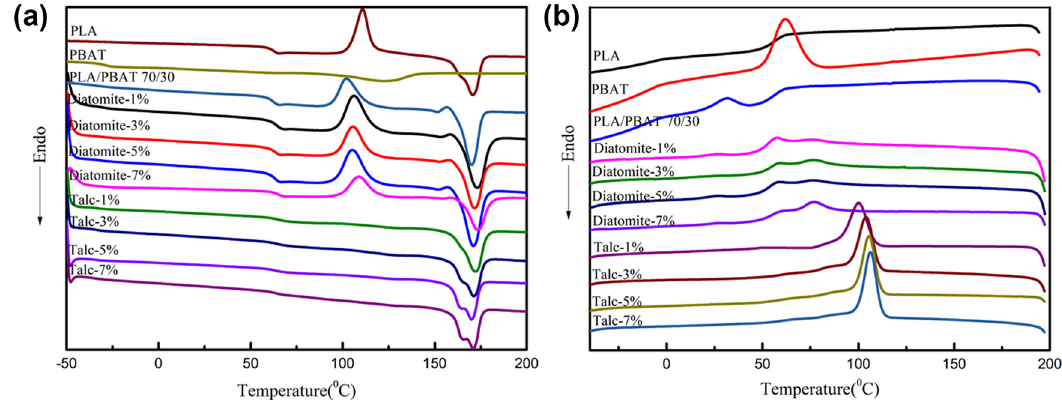
Figure 2: DSC curves of the PLA/PBAT blends: ( a ) blends second heating ramp, ( b ) blends cooling